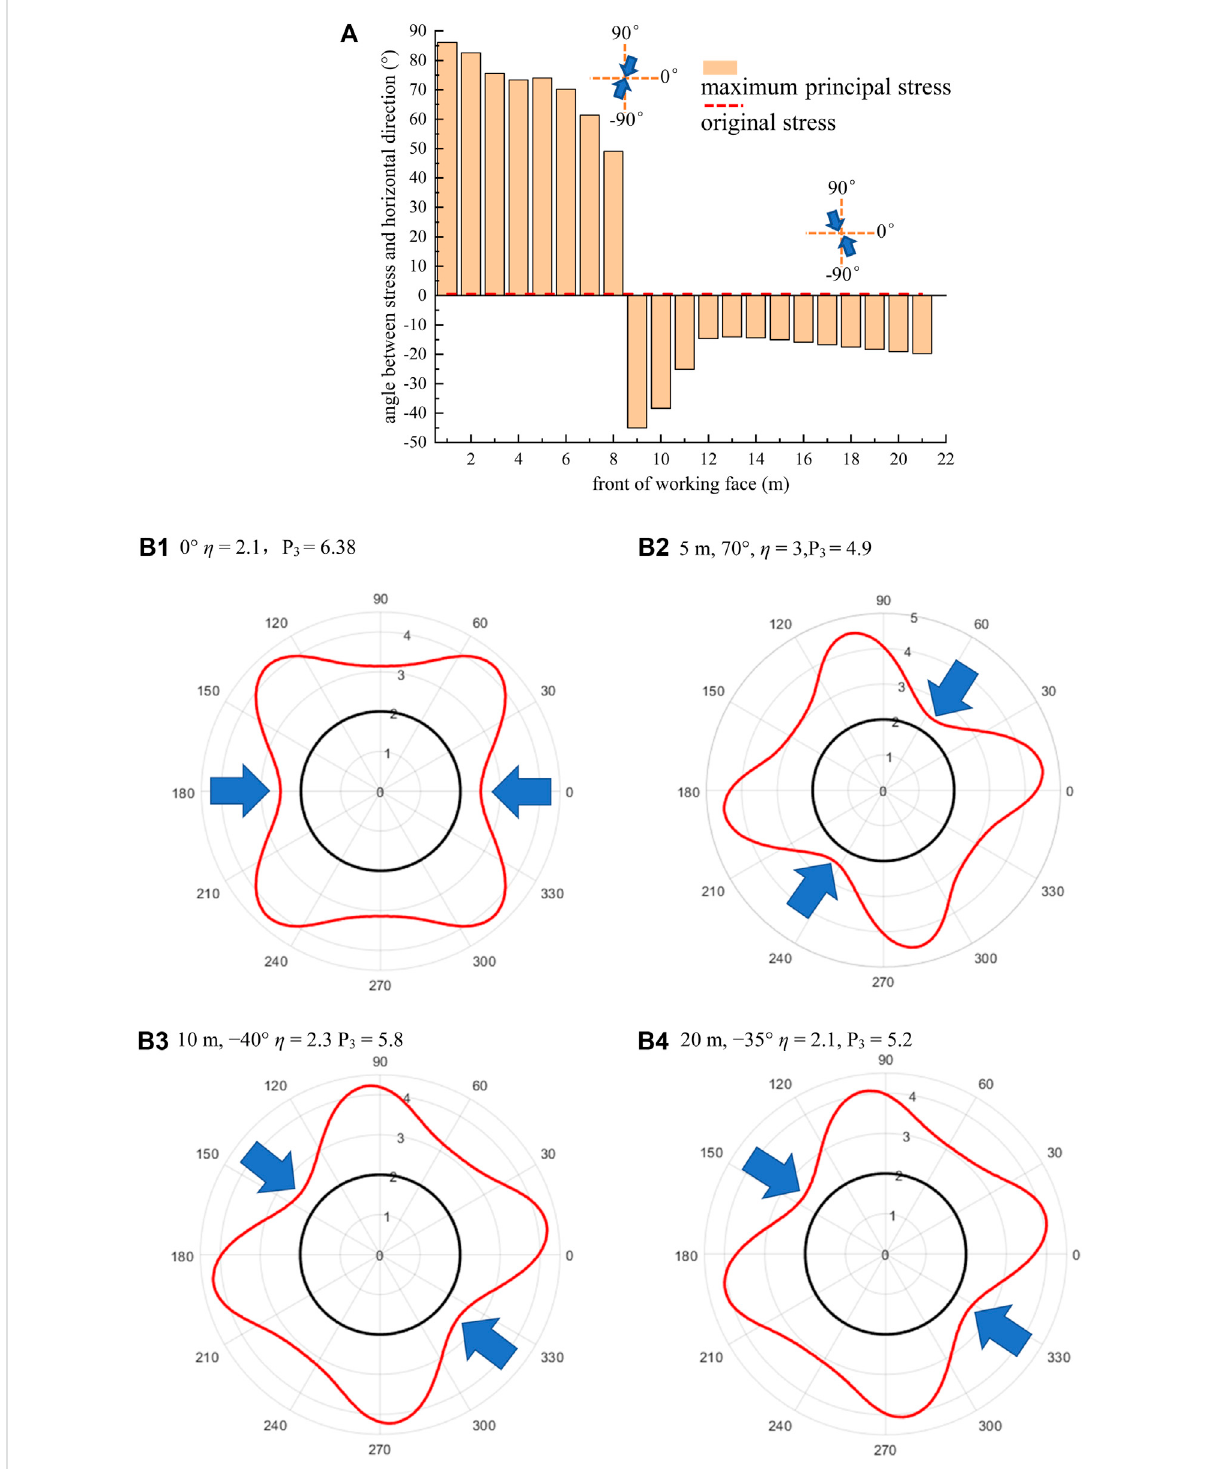
FIGURE 9 (A) Variation of the principal stress direction. (B) In fl uence of principal stress direction on the plastic zone of the surrounding